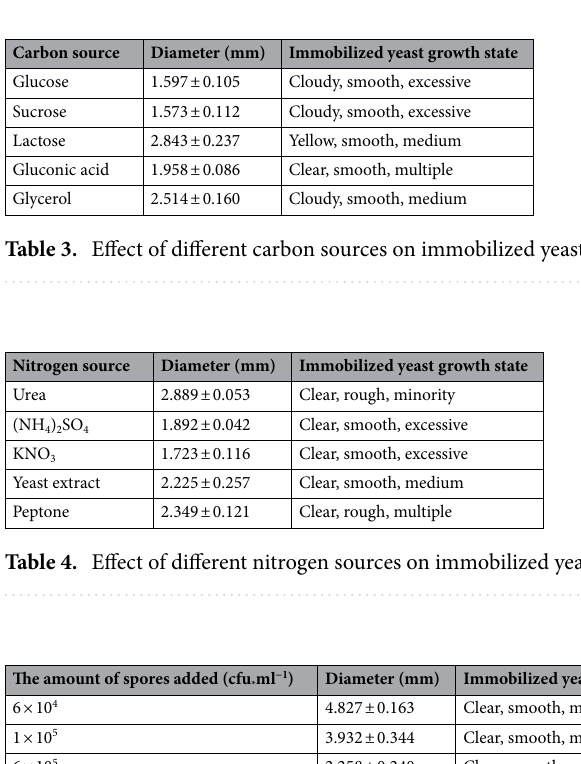
The amount of spores added (cfu * ml −1